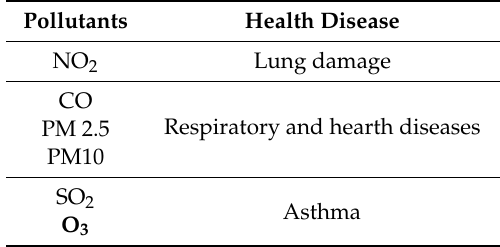
Table 4. Diseases due to pollutants. PM: particulate